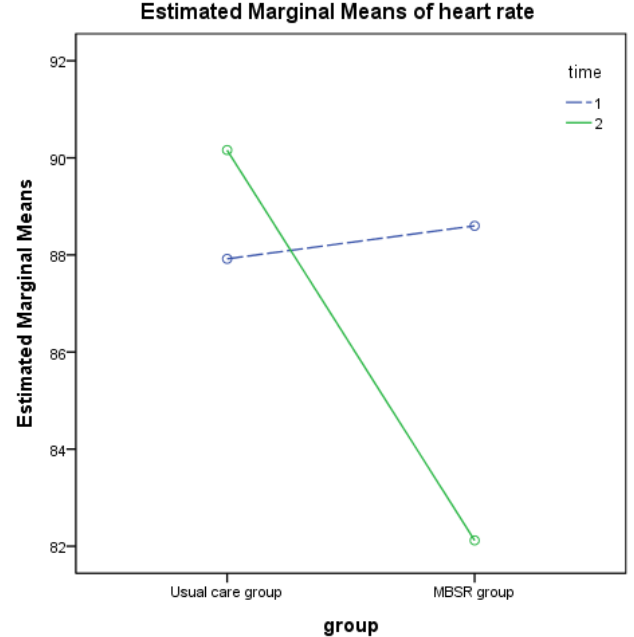
Figure 2. Profile plot showing two-way ANOVA for heart rate on MBSR